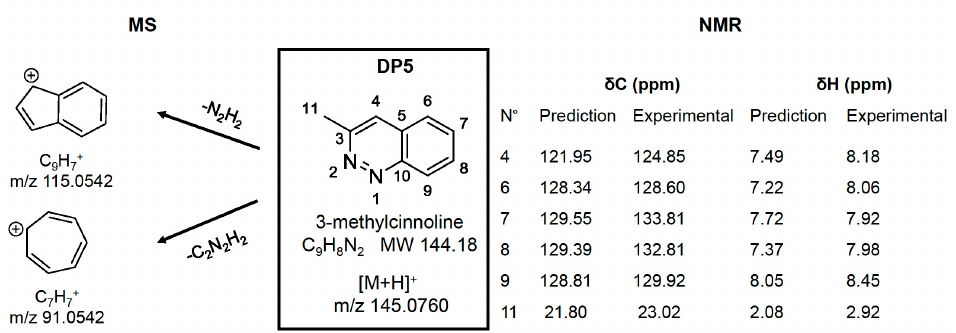
Figure 5. DP5 structural elucidation using the combined MS-NMR approach.